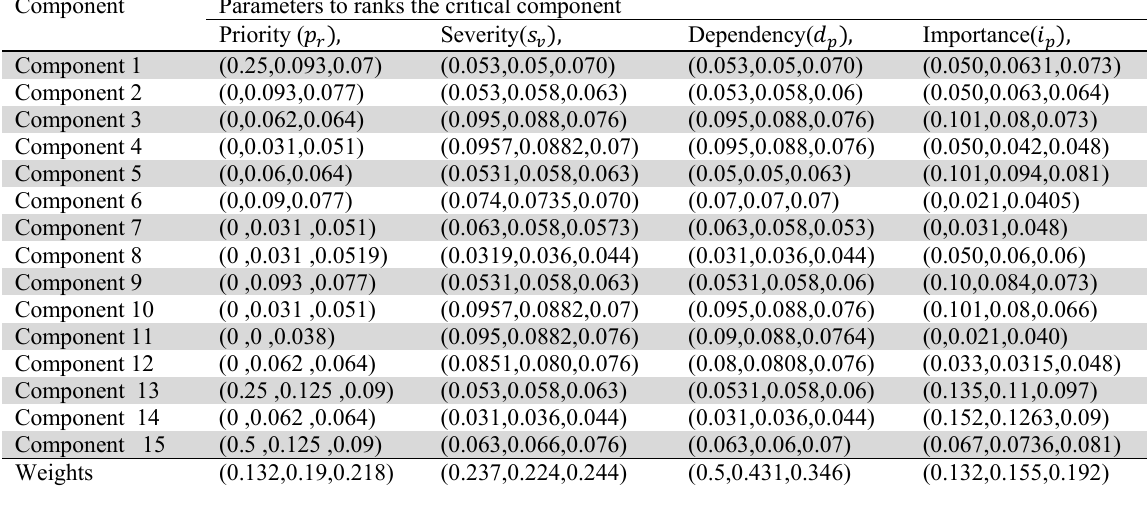
Fuzzy normalized decision